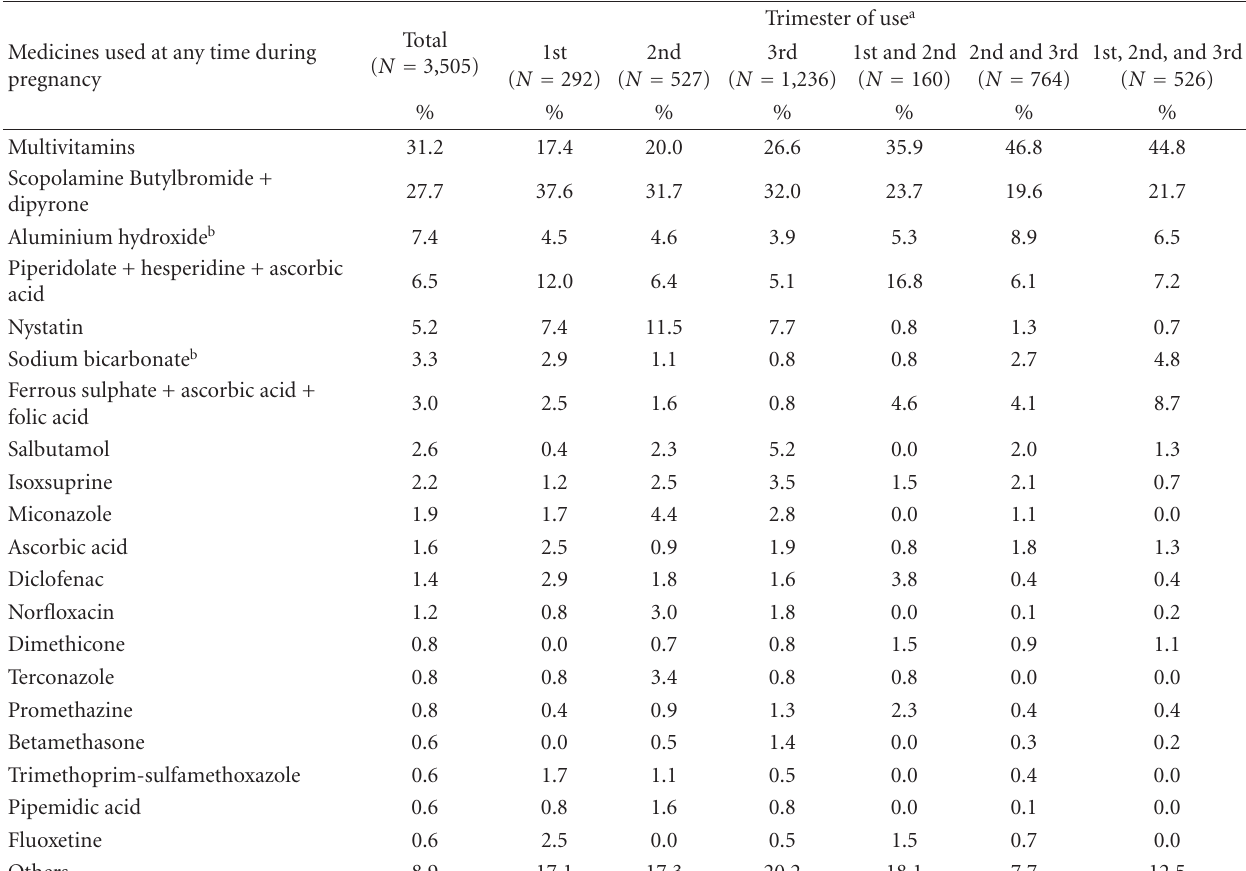
Table 2: Most used medicines by the mothers participating in the 2004 Birth Cohort classified as unknown fetal risk, by the gestational trimester of medicine use. Birth Cohort of Pelotas, RS